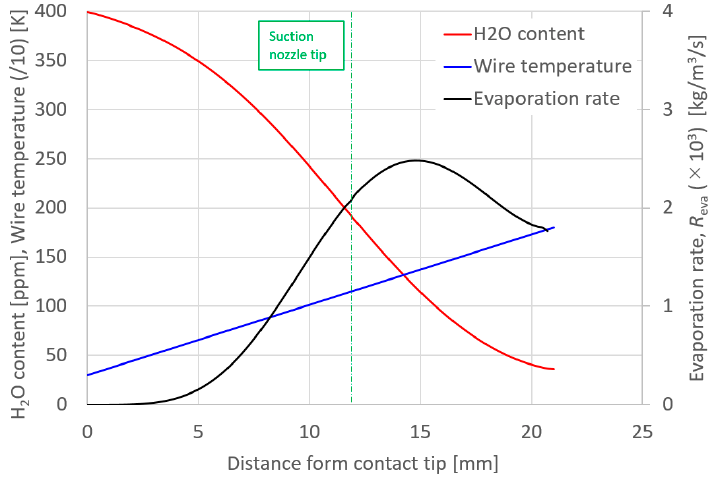
Figure 4. Axial distribution of the H 2 O content in wire, wire temperature and H 2 O evaporation rate.